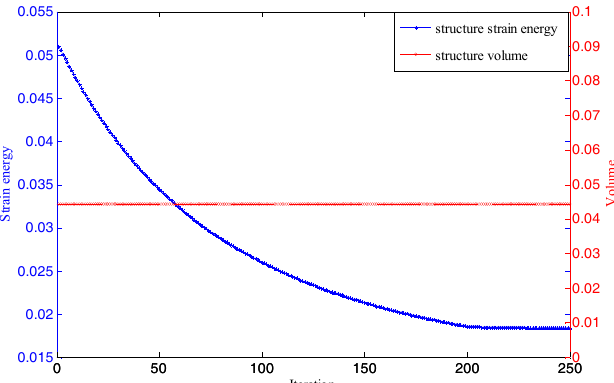
Figure 10. Iteration histories of the objective and volume for cantilever beam.